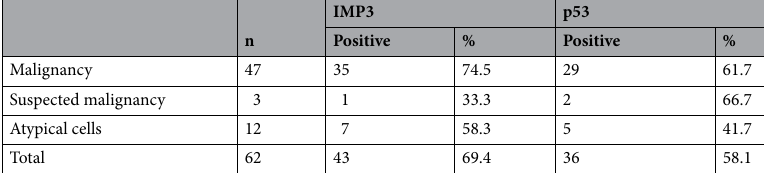
Table 7. Immunohistochemical staining in PDAC according to histological result.